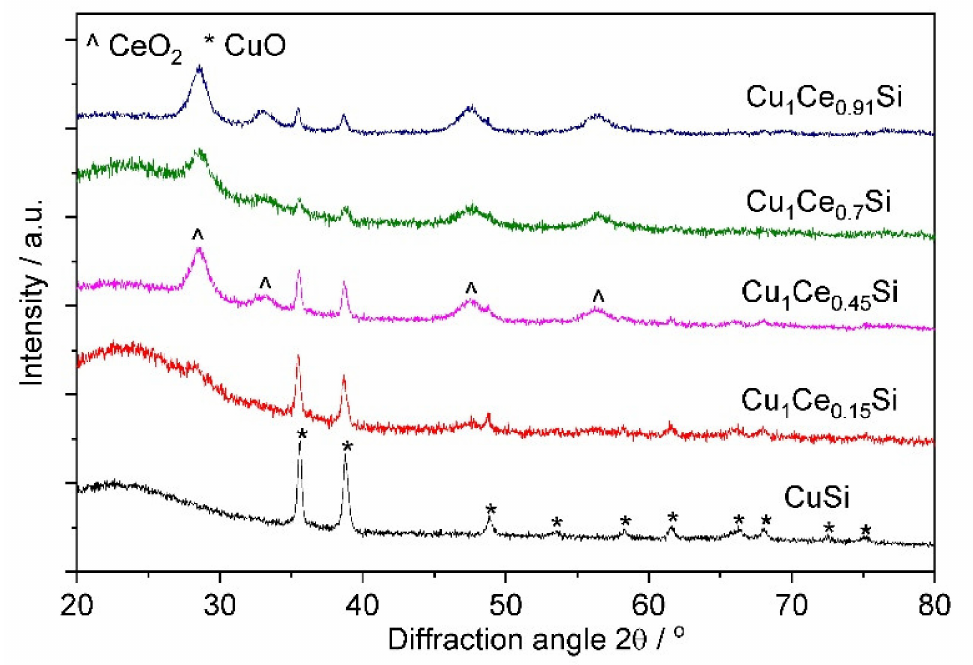
Figure 1. PXRD patterns of the as-prepared composite